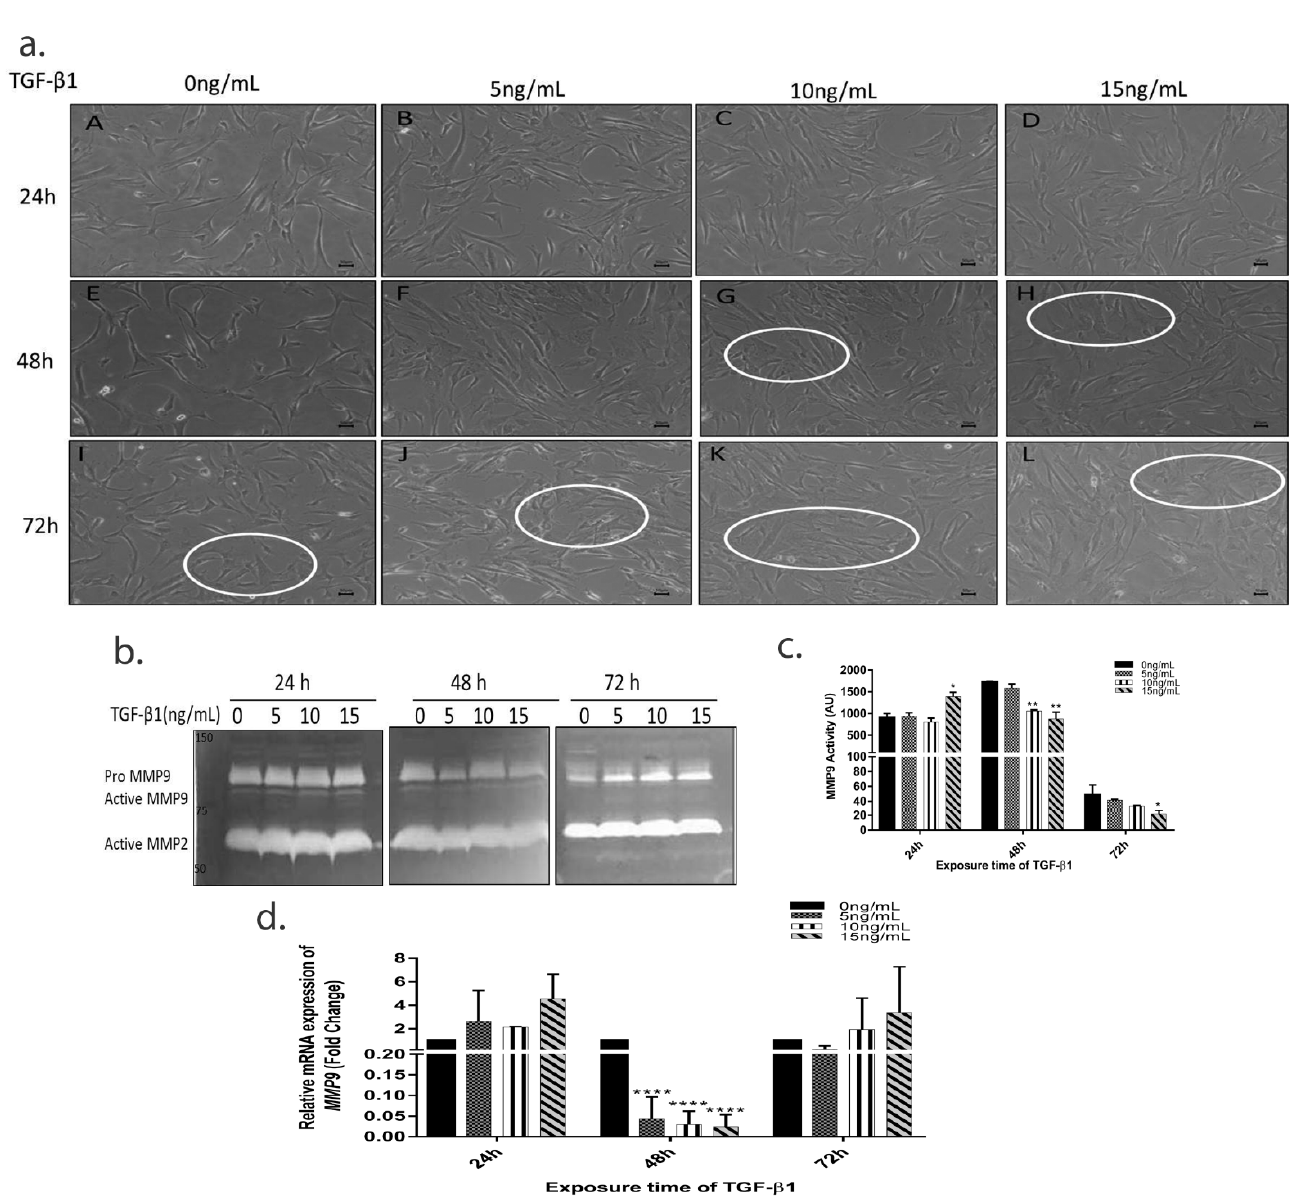
Figure 2. TGF- β 1 induces morphological changes and effects functional activity of MMP9. ( a ) Panel ( A – L ) depicts representative photomicrographs of TM cells after TGF- β 1 treatment. Circles show flattened, elongated, spindle shaped morphology of TM cells representing EMT. Bar = 50 µ M. ( b ) MMP9 activity visualized by gelatin zymography ( c ) Quan- tification of MMP9 activity in arbitrary units using ImageJ, ( d ) relative mRNA expression of MMP9 gene after TGF- β 1 treatment. The error bars represent standard deviation (* p < 0.05, ** p < 0.01, **** p < 0.0001, by one way